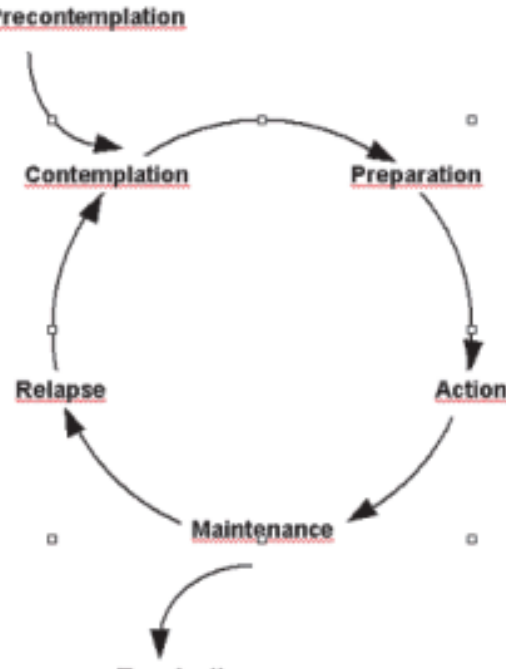
Figure 2 The readiness of change cycle adopted from Prochaska and DiClemente